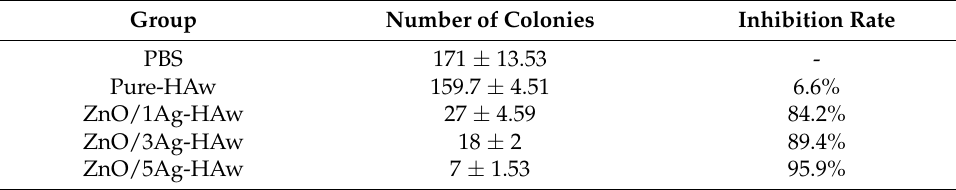
Table 8. Number of S. aureus plate colonies in different samples. Group Number of